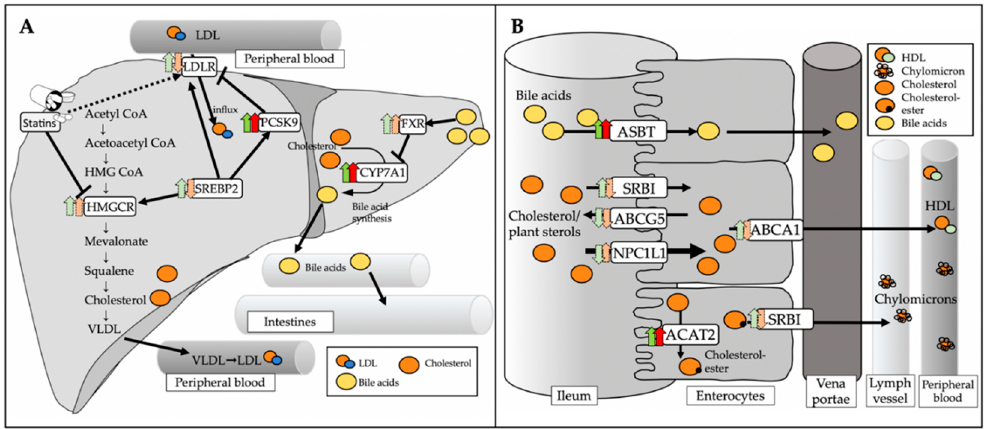
Figure 8. Role of key regulating genes involved in hepatic and intestinal cholesterol metabolism. ( A ): SREBP2 is a major transcription factor regulating intracellular cholesterol homeostasis. It activates the transcription of LDLR, HMGCR and PCSK9 to control cholesterol uptake by LDLR in a self-regulating circuit. CYP7a1 catalyzes the rate limiting step of hepatic bile acid synthesis. FXR, which is primarily activated by bile acids, regulates bile acid synthesis by CYP7a1 via a negative feedback loop. ( B ): NPC1L1 is the major transporter protein for intestinal cholesterol absorption. To a lesser extent, SRBI is also involved in cholesterol absorption and secretion into lymph. Free cholesterol is esterified by ACAT2 for further processing into chylomicrons. Excessive free cholesterol is secreted back into the intestinal lumen by ABCG5. ABCA1 mediates the efflux of cholesterol directly into the blood stream. ASBT is the major transporter protein for reabsorption of bile acids within the enterohepatic circulation. Green arrows indicate changes (dark green represents significant changes, bright green represents trends) in CONV HFD+Ator mice compared to CONV HFD mice. The red arrows indicate changes (dark red represents significant changes, bright red represents trends) in ABS HFD+Ator compared to ABS HFD mice.